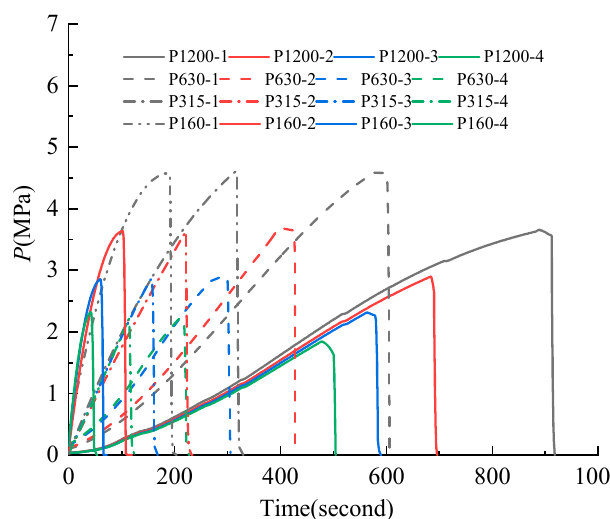
Figure 14. Internal pressure loading curve.